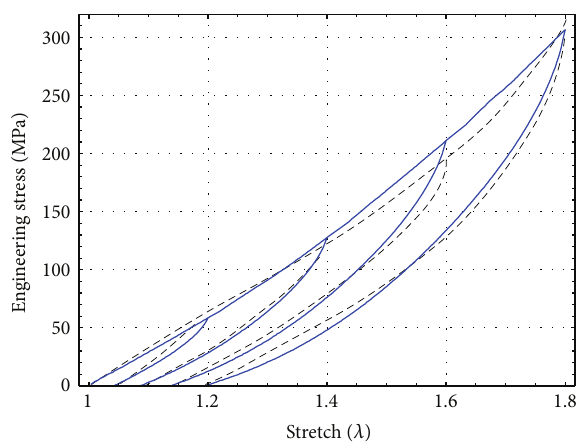
Figure 4: Engineering stress-stretch data for polyglycolic acid sutures compared with theoretical predictions of the nonmonoto- nous amended average-stretch, full-network model for which 𝜇 = 385 MPa, 𝑁 = 70.5 , 𝑏 = 1.3 , and 𝐶 = 0.001 MPa. The dashed black lines represent theoretical predictions, and the blue solid lines describe experimental data.